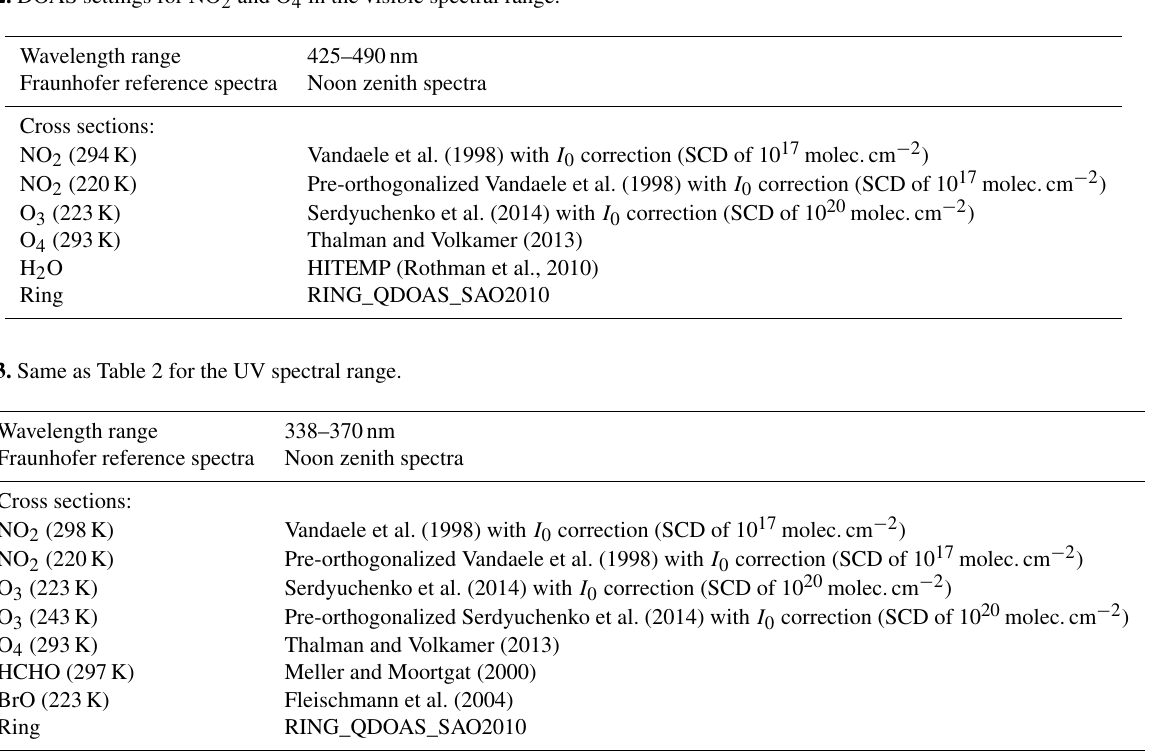
Table 2. DOAS settings for NO 2 and O 4 in the visible spectral range.